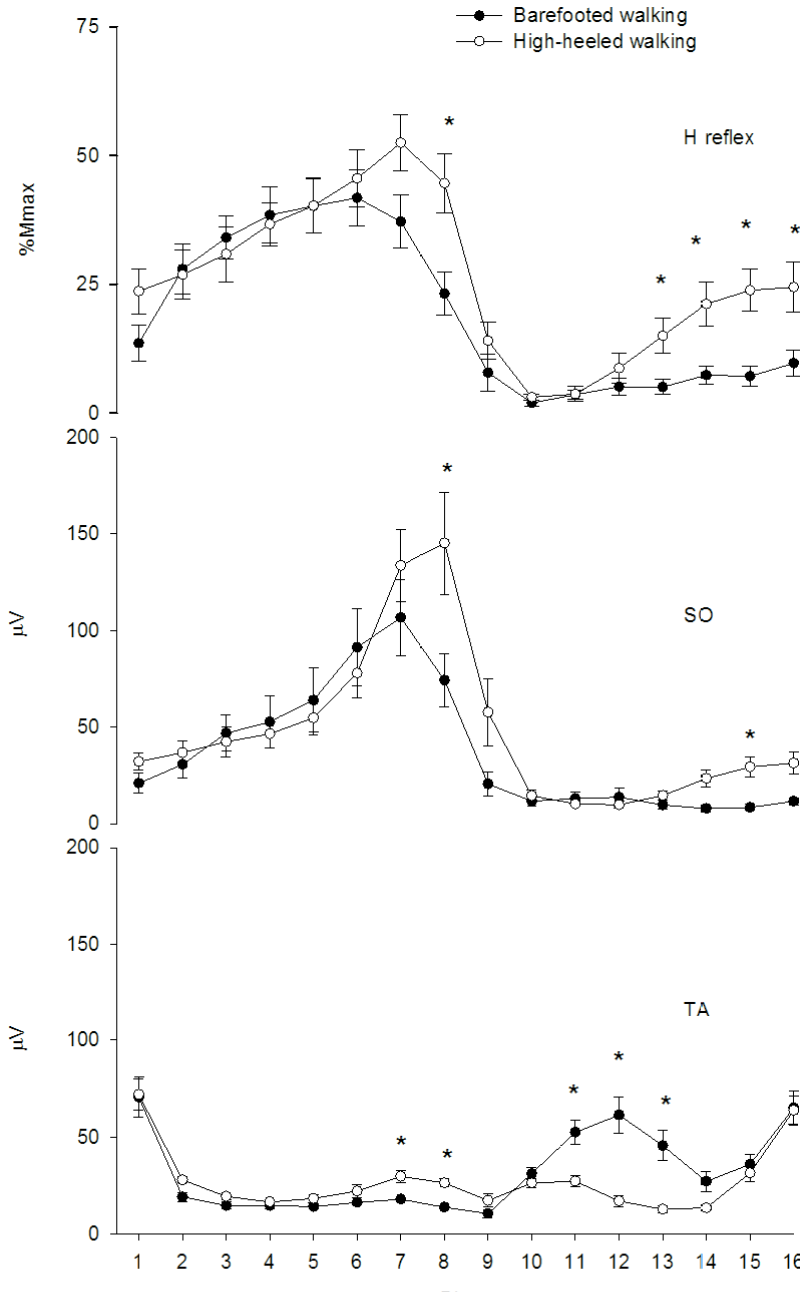
Figure 5. Mean SO H-reflex modulation and EMG activity. From the top: The mean SO H-reflex amplitude (% Mmax) and EMG activity ( m V) of SO and TA during barefooted (filled circles) and high-heeled (open circles) walking for the whole group (n=11). Gait cycle has been divided into 16 bins. Transition from stance to swing phase occurs at bin 10. Values are means 6 SE. Asterisks indicate statistically significant differences between the two walking conditions.